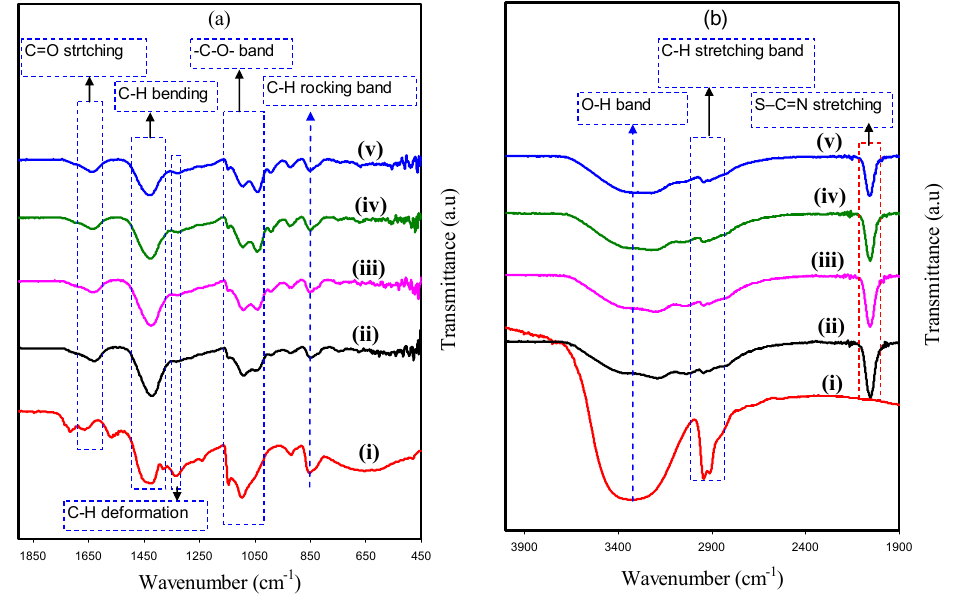
Figure 2. FTIR spectra for ( i ) pure PVA, ( ii ) PNCG-1, ( iii ) PNCG -2, ( iv ) PNCG-3, and ( v ) PNCG-4 in the region ( a ) 450–1900 cm − 1 and ( b ) 1900–4000 cm − 1 .